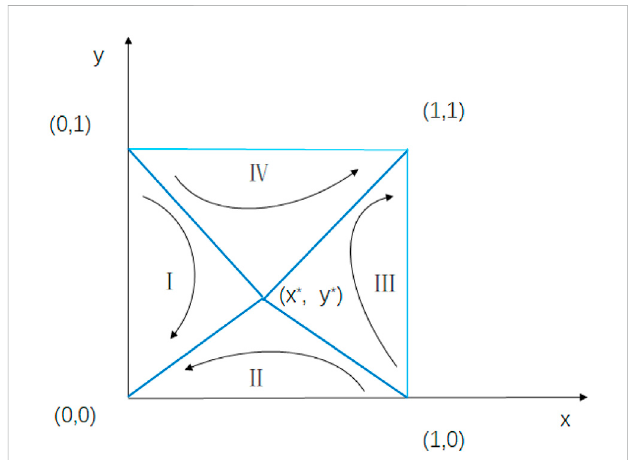
FIGURE 1 Dynamic path diagram of equilibrium point of evolutionary game model between the local government and coal mining